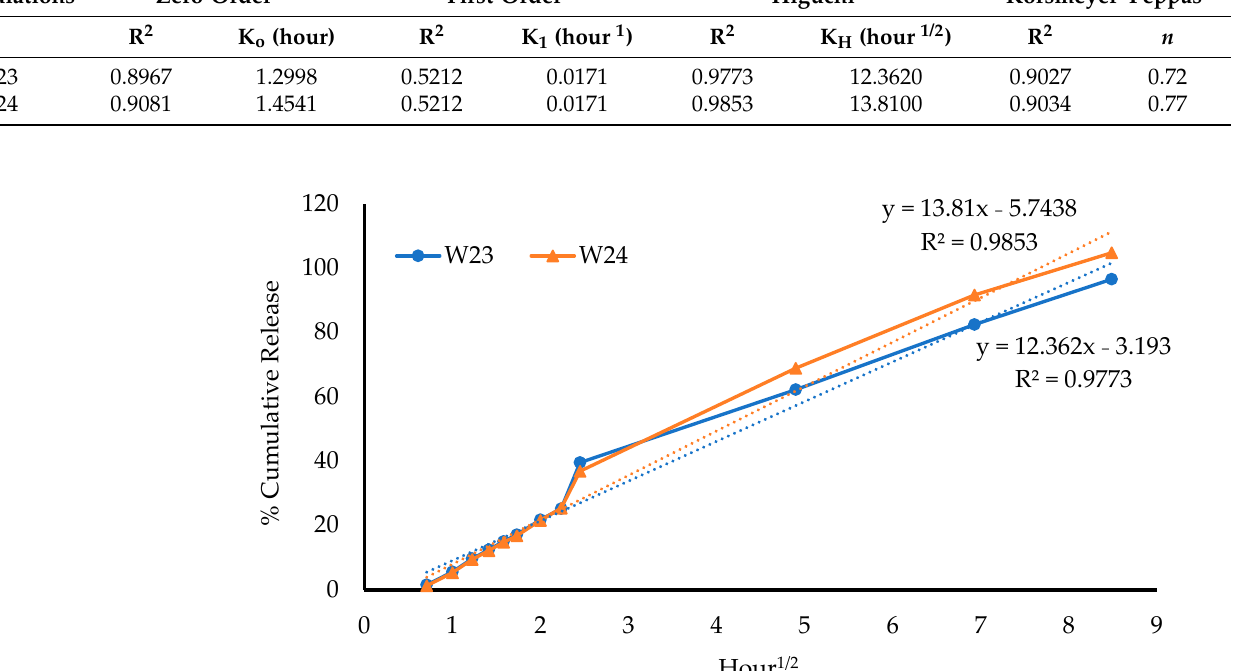
Table 7. Release parameters of DL wafers in SVF developed by fitting experimental drug dissolution (release) data to different kinetic equations.